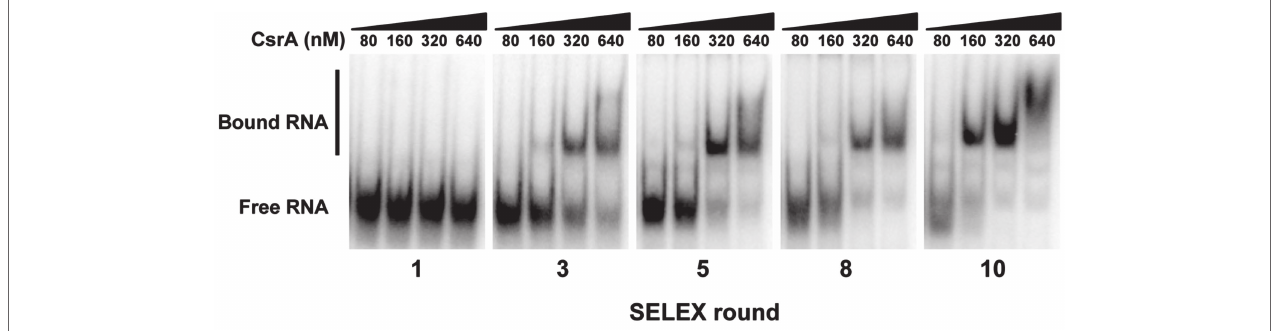
FIGURE 1 | Identification of high-affinity RNA ligands for C. jejuni CsrA using in vitro SELEX. A complex mixture of oligonucleotides was designed containing PCR primers flanking a random N 15 central region. RNAs transcribed in vitro from this mixture were bound to CsrA-His 6 , purified, converted to cDNA, then the enriched pool was subsequently used in a total of 10 rounds of SELEX. To monitor the progress of SELEX, gel shift assays were performed using increasing concentrations of purified